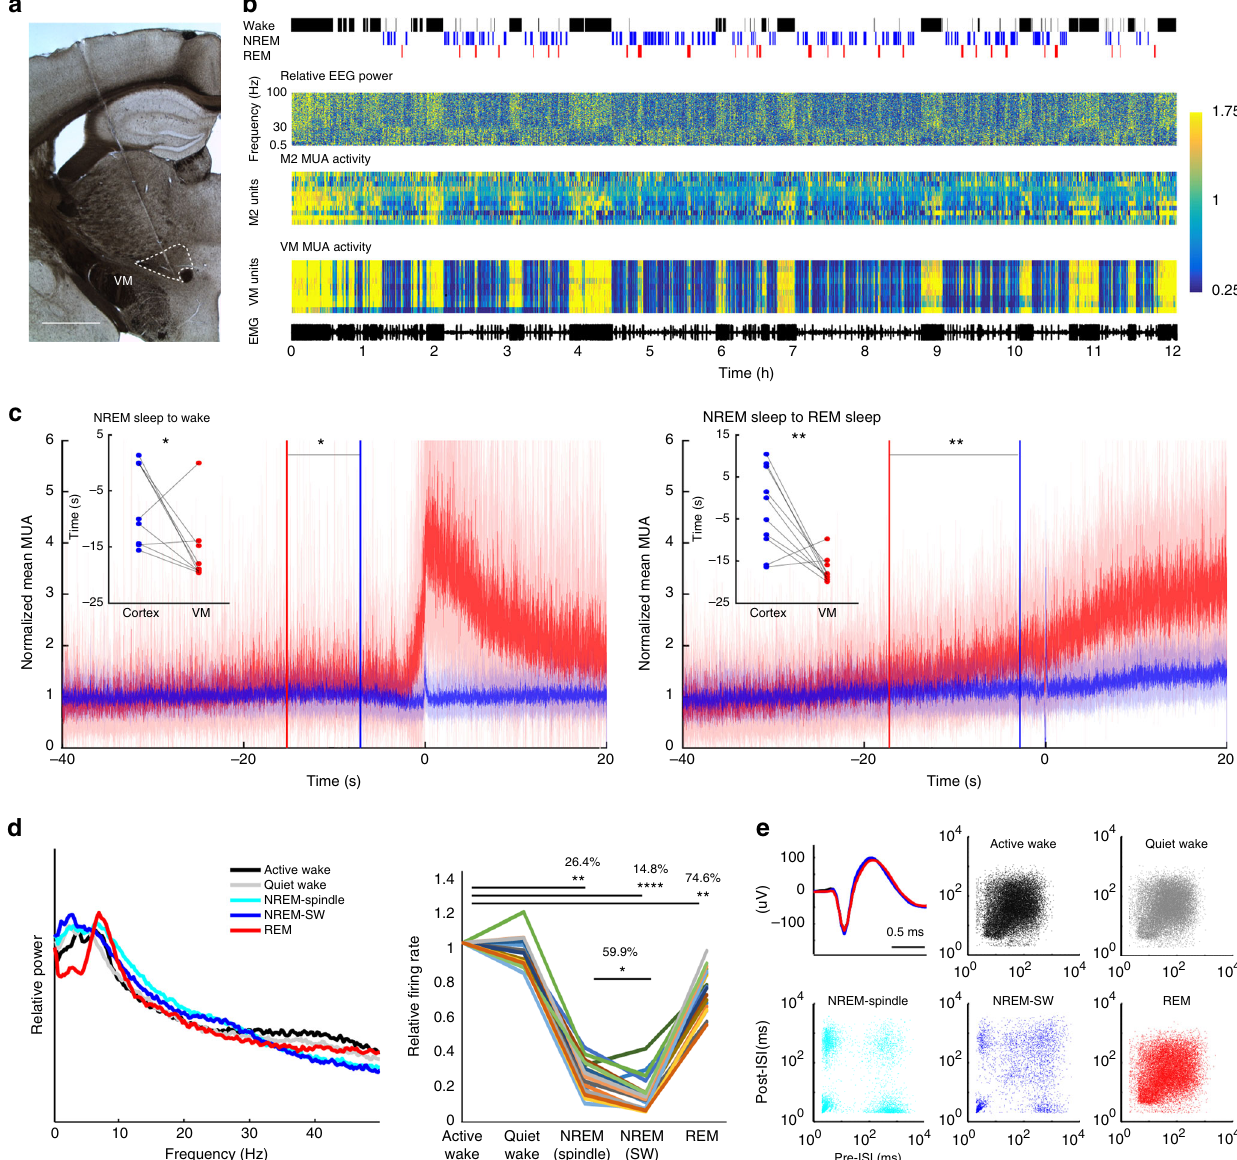
Fig. 1 VM activity is state dependent. a Electrode placement for VM recording. Scale bar, 1 mm. b From top; representative hypnogram showing manually scored vigilance states during the light period. Relative EEG power in parietal cortex, normalized to the 12 h mean for each frequency ( Y axis, 0.5 – 100 Hz, 1 Hz bin). MUA in M2 and VM (4-s epochs, normalized to the 12 h mean). Color bar represents relative changes for all three panels. M2 channels are arranged from super fi cial to deep layers. EMG electromyogram. c Mean MUA changes across state transitions (10 mice; M1 + M2 in blue, VM in red, solid line and shaded area; mean ± std). Each channel was averaged across the 12 h light period and values were normalized to the mean of baseline activity of each channel calculated between − 40 and − 20 s from time 0. Time 0 identi fi es the automatically detected awakening from NREM sleep based on EMG activity (left) or cortical activation at the onset of REM sleep (right, de fi ned as the end of the last off period). The time interval between when MUA starts exceeding mean + 5 std of baseline and time 0 is shown for each mouse (dots) and averaged across all mice (blue and red vertical lines). Across mice MUA increased earlier in VM than in cortex (mean ± std in s, left; NREM-to-wake, M1 + M2 = − 7.14 ± 7.29, VM = − 15.91 ± 6.32, * p < 0.05, right, NREM- to-REM, M1 + M2 = − 2.85 ± 9.84, VM = − 17.23 ± 3.072, ** p < 0.005, paired t -test). d Left, EEG power spectrum across vigilance states, for epochs used for spike sorting. Middle, mean VM fi ring rates normalized to active wake (each line is one neuron; 20 single units, 6 mice). * p < 0.01, ** p < 5 × 10 − 5 , *** p < 5 × 10 − 6 , paired t -test). e Top left, representative waveforms of a VM single unit (average waveforms of 50 randomly selected spikes from each vigilance state). The other panels show 2D log-scale inter-spike interval scatterplots for the same VM neuron across vigilance states ( x axis and y axis, interval in ms to previous and post spike,